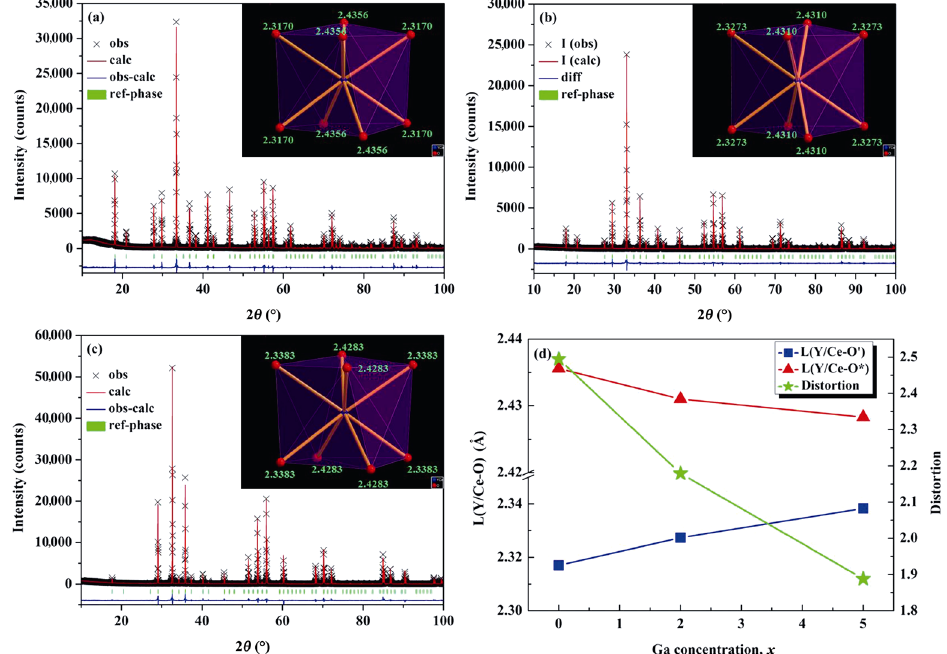
Fig. 3 Rietveld refinements for Y 3 Al 5– x Ga x O 12 :Ce ceramics, where x is equal to (a) 0, (b) 2, and (c) 5. The insets are coordinate environments of Ce/Y with oxygen atoms, (d) Ce/Y–O bond lengths and CeO 8 polyhedron distortion change with Ga